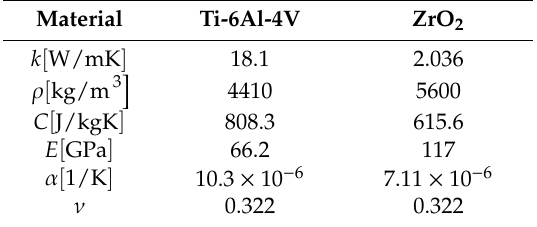
Table 1. Material properties of ceramic (ZrO 2 ) and metal (Ti-6Al-4V) [11].